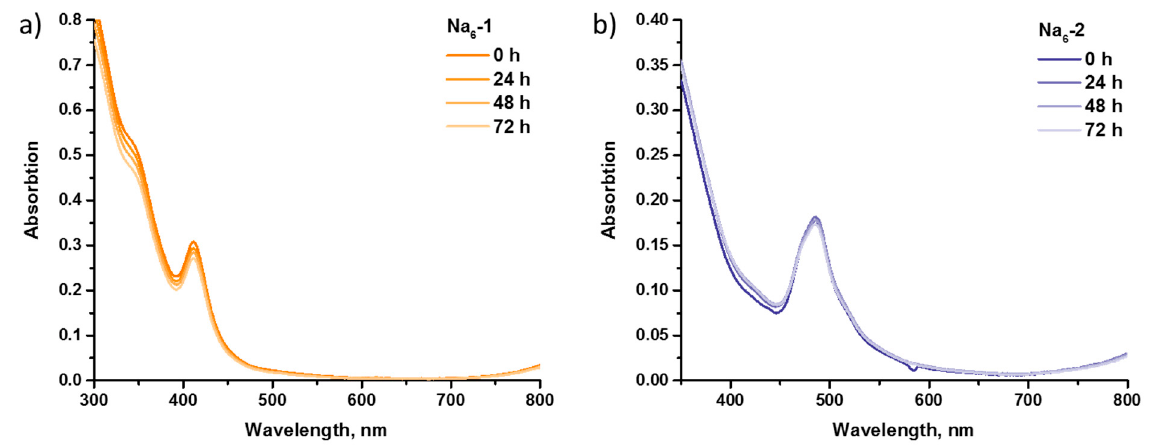
Figure 5. UV–Vis spectra of Na 6 - 1 ( a ) and Na 6 - 2 ( b ) in time in culture medium.